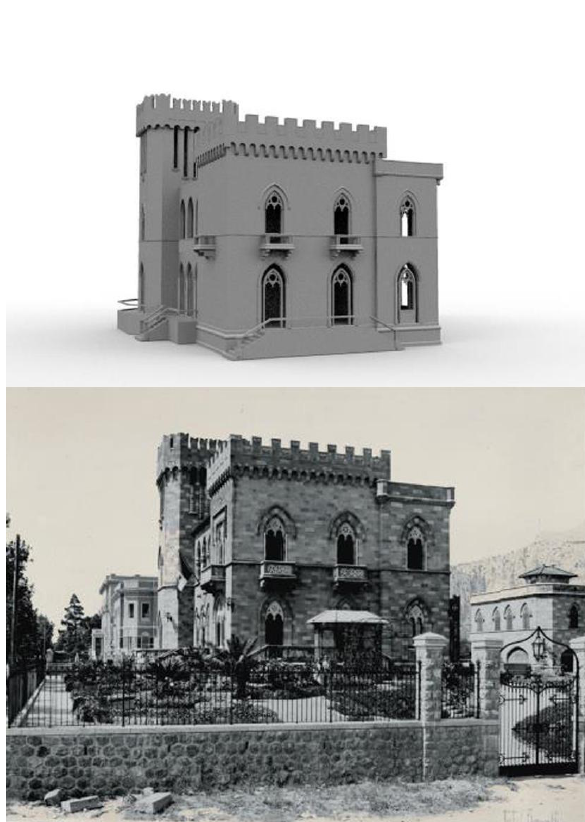
Figure 3 . Three-dimensional reconstruction and relative historical photo.